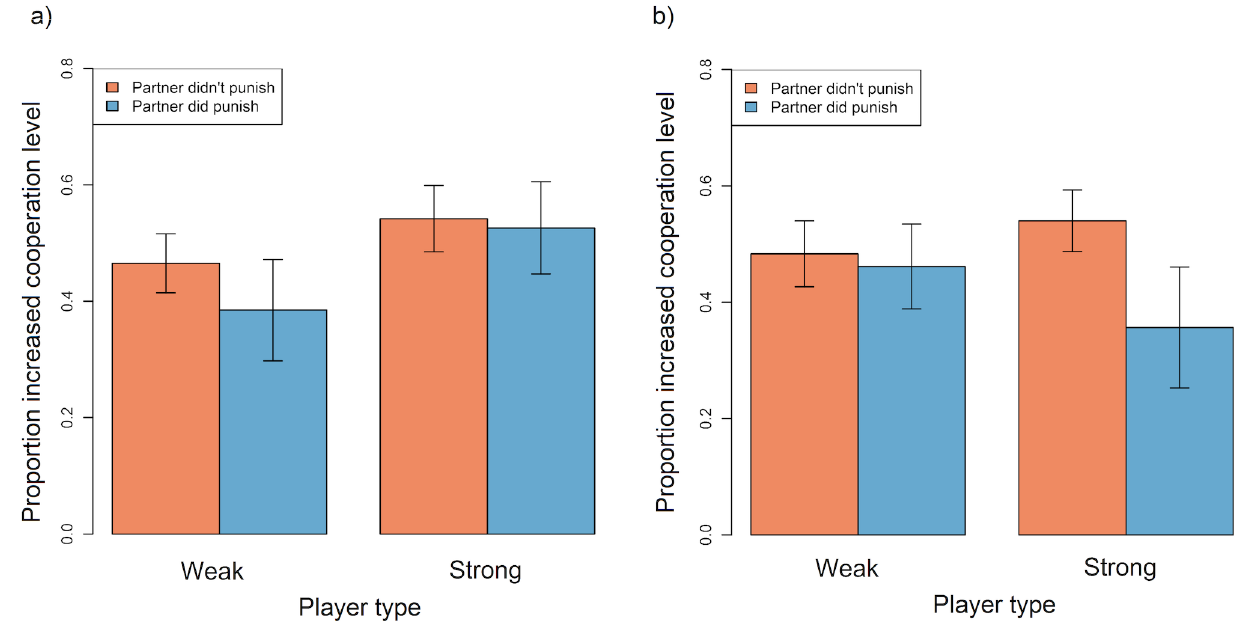
Fig 4. Barplot showing the mean proportion of instances in which weak and strong players in a) symmetric games and b) asymmetric games increased their cooperation level in round n+1 relative to round n , according to whether or not they were punished by their partner in round n . Data were restricted to instances where the focal player chose a lower cooperation level than their partner in round n and exclude instances where either player opted out in round n or n+1 . Error bars represent standard errors. Plots are generated from raw